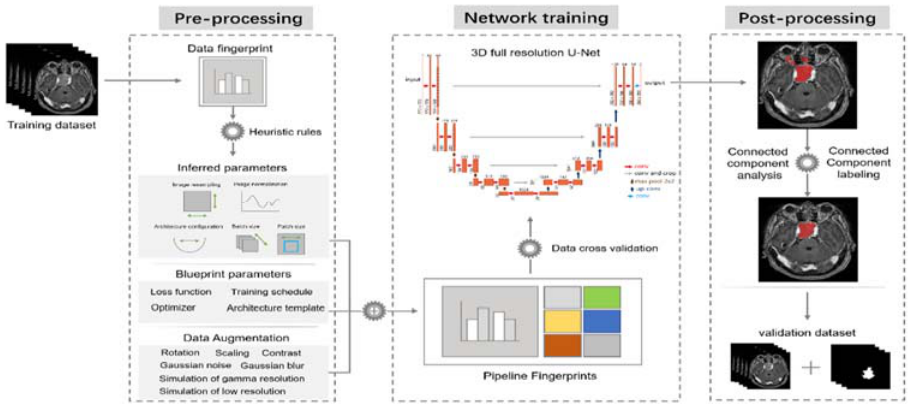
Figure 1. Flowchart of nnU ‐ Net pipeline. To ingest training data, nnU ‐ Net uses heuristic rules to determine the data ‐ dependent hyper ‐ parameters, referred to as the “data fingerprint”. Inferred parameters, blueprint parameters, and data fingerprints produce pipeline fingerprints, which produce network training for 3D U ‐ Net using the hyper ‐ parameters determined so far. The ensemble of network configurations, in combination with post ‐ processing, determines the best average Dice coefficient for the training data.